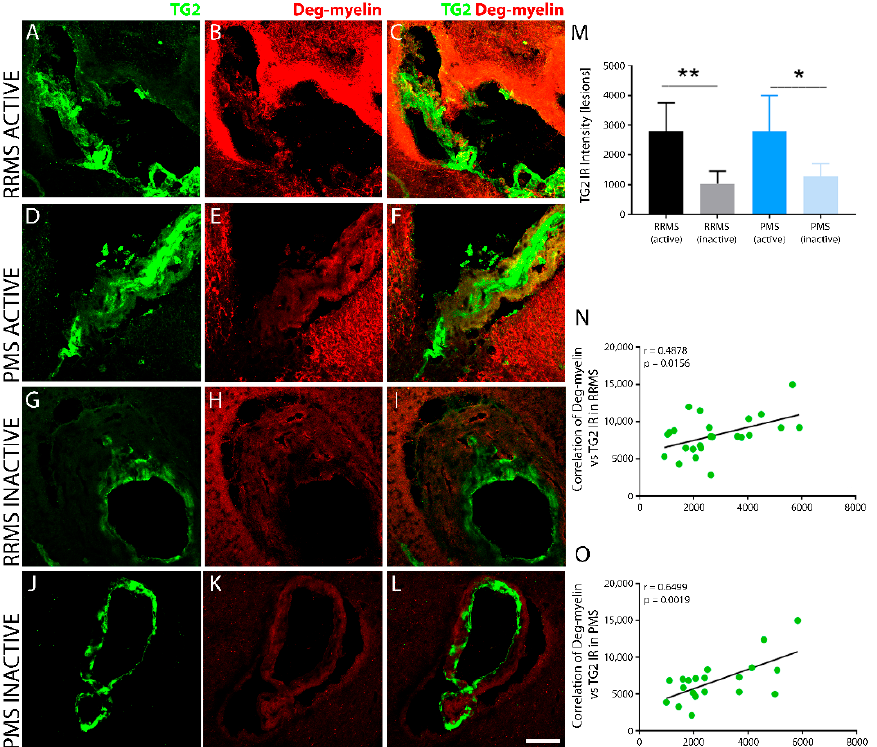
Figure 3. TG2 expression correlates with degraded myelin in active lesions after MS. Active lesions in brain tissues from both RRMS ( A – C ) and PMS ( D – F ) showed elevated levels of TG2 ( A , C and D , F ) respectively. TG2 correlated with levels of degraded myelin surrounding sclerotic plaques of both forms of MS ( B , C and E , F , respectively). Inactive lesions from RRMS ( G – I ) and PMS ( J – L ) exhibited reduced levels of TG2 and degraded myelin. Quantitative assessment of TG2 levels in sclerotic plaques of both RRMS and PMS brain tissue exhibited significant differences in TG2 expression levels between active and inactive lesions ( M ). Scale bar = 50 μ m. Data were quantified and expressed as value of the mean plus the standard deviation (SD). Statistical significance indicated a * p < 0.05; ** p < 0.01, determined using a 1-way analysis of variance and post hoc Tukey test. Degraded myelin immunoreactivity showed a significant, positive correlation with the extent of TG2 expression in lesioned tissue after both RRMS ( N ) and PMS ( O ). The correlation between levels of degraded myelin and TG2 IR in the lesions from all the patients in each of the two forms of MS is shown in ( N , O ). The p ‐ value determined by linear regression and Pearson correlation coefficient (r) is indicated for each of the analyses.